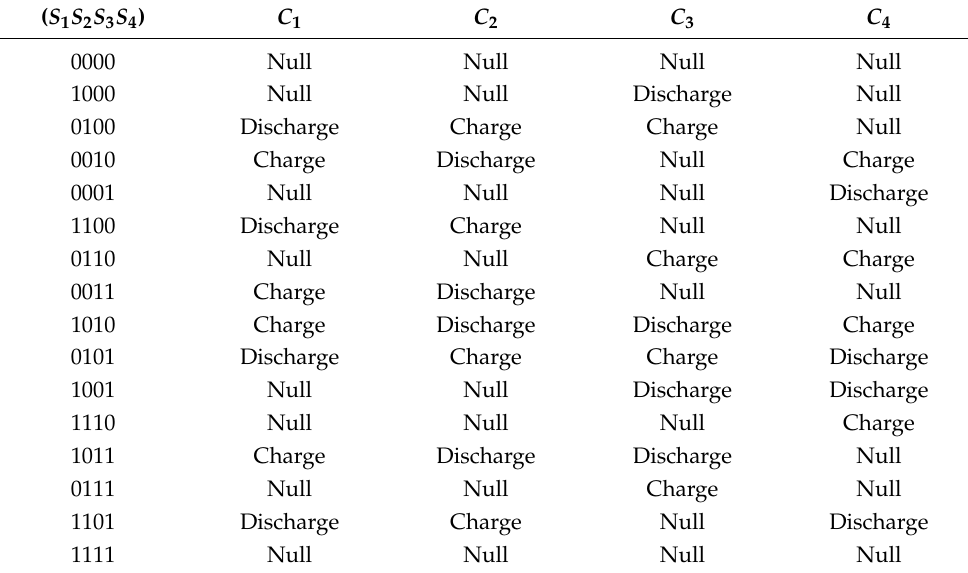
Table 2. The relationship between switching states and the charge–discharge of DC-side